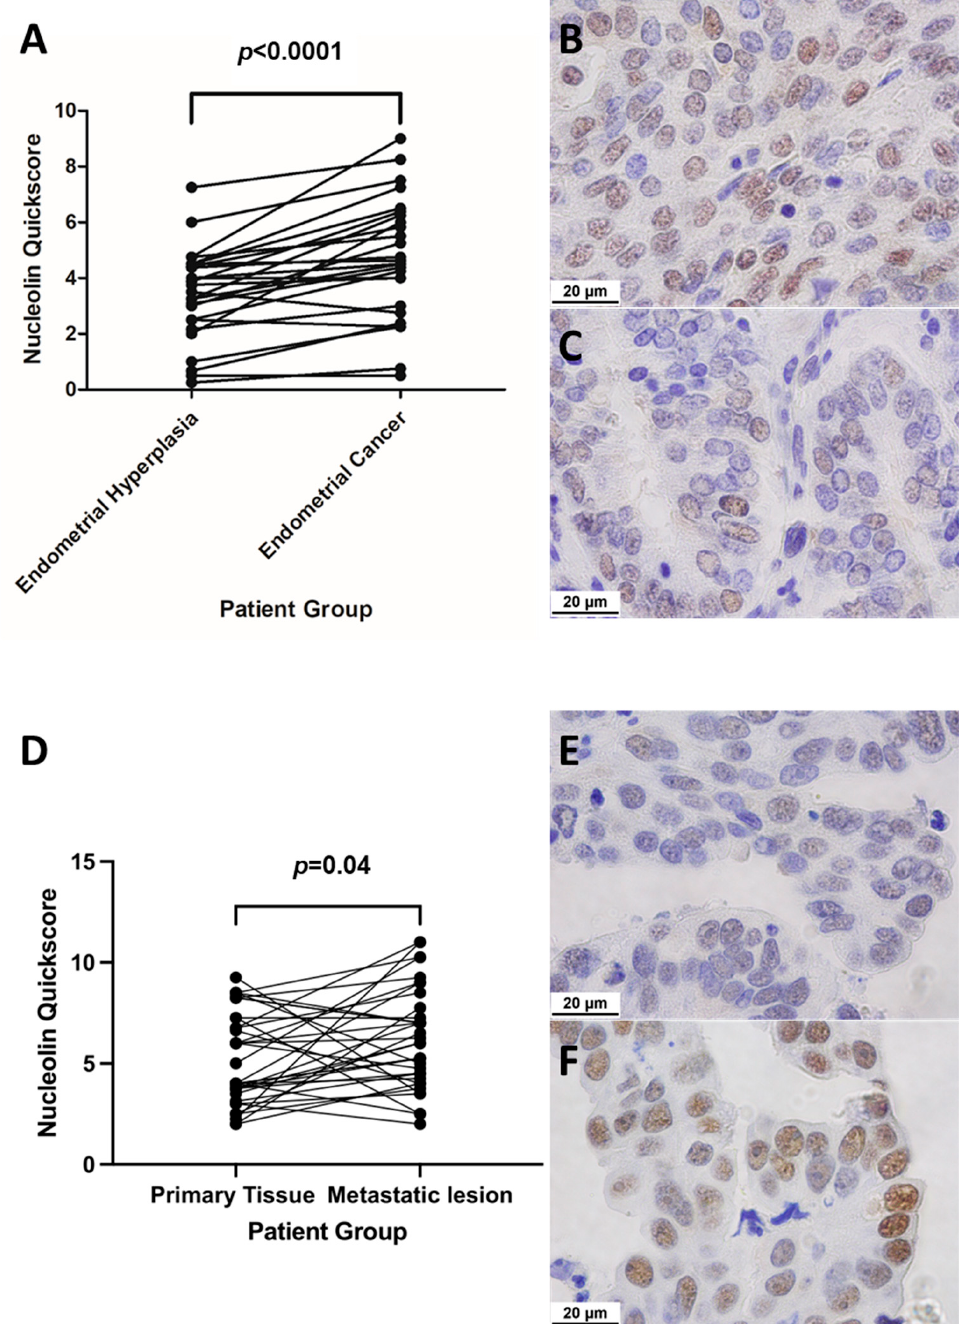
Figure 4. ( A ) Graph showing Wilcoxon matched pairs test in women diagnosed with both EH and EC ( n = 26). Representative micrographs showing nucleolar NCL staining in ( B ) EC (median quick score = 4.6) and ( C ) matched EH (median quick score = 3.6). ( D ) Graph showing Wilcoxon matched pairs test in women diagnosed with metastatic EC, showing nucleolar NCL quick score in primary endometrial tissue ( n = 27) and matched metastatic lesions ( n = 35). Representative micrographs showing nucleolar NCL staining in ( E ) EC (median quick score = 4) and ( F ) matched metastatic lesion (median quick score = 6). Positive staining indicated by brown nucleoli. All images seen at × 1000 magnification. Scale bar = 20 µ m, applicable to all